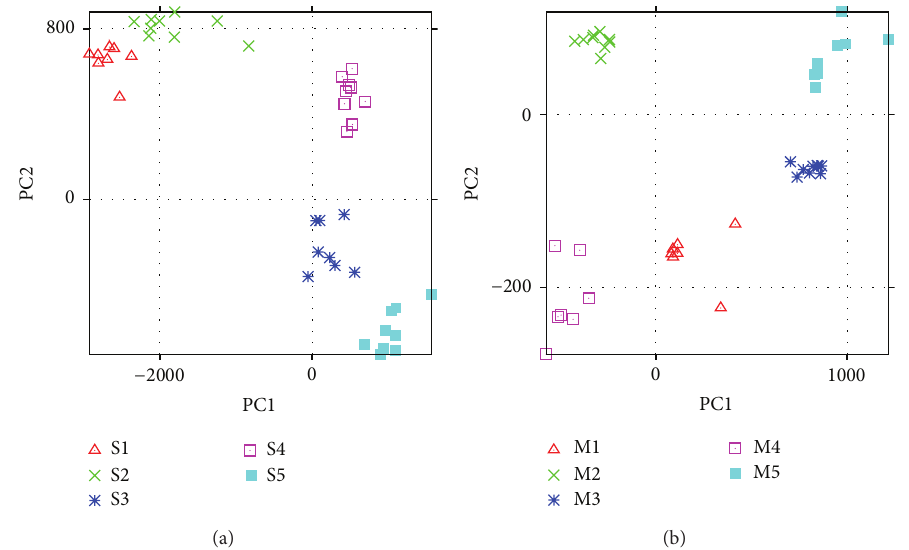
Figure 5: Intersubject variability represented by first and second principal components of five different subjects (a) MIT-BIH Arrhythmia database and (b) IIT(BHU) database.